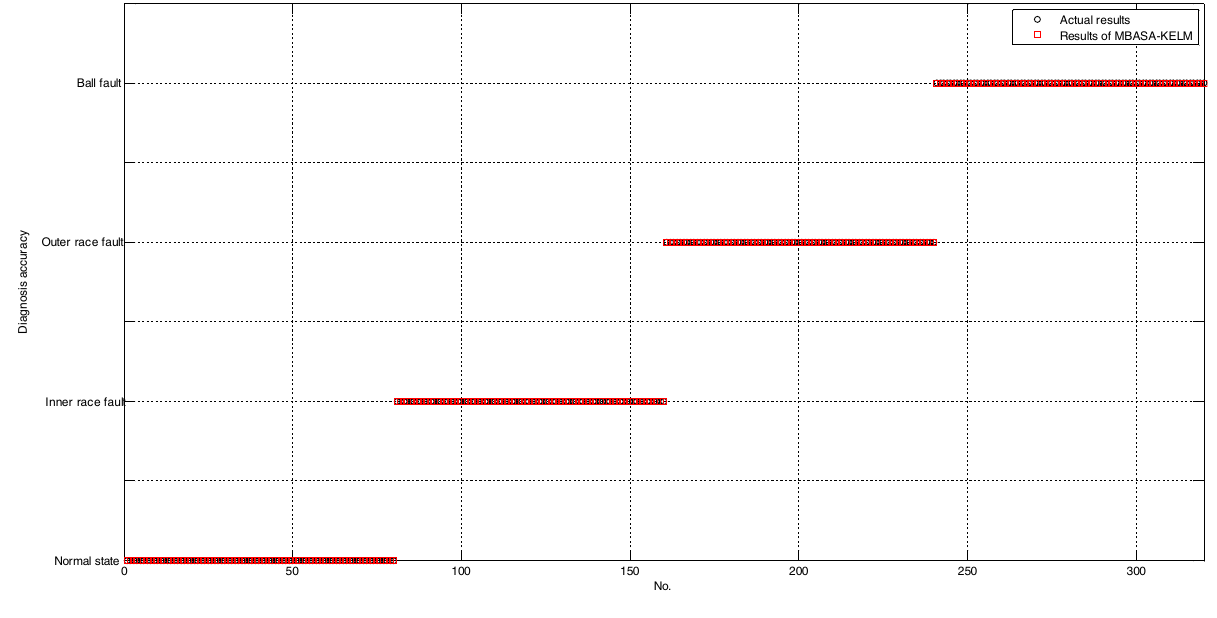
Figure 4. The diagnosis results of bearing based on MBASA-KELM.